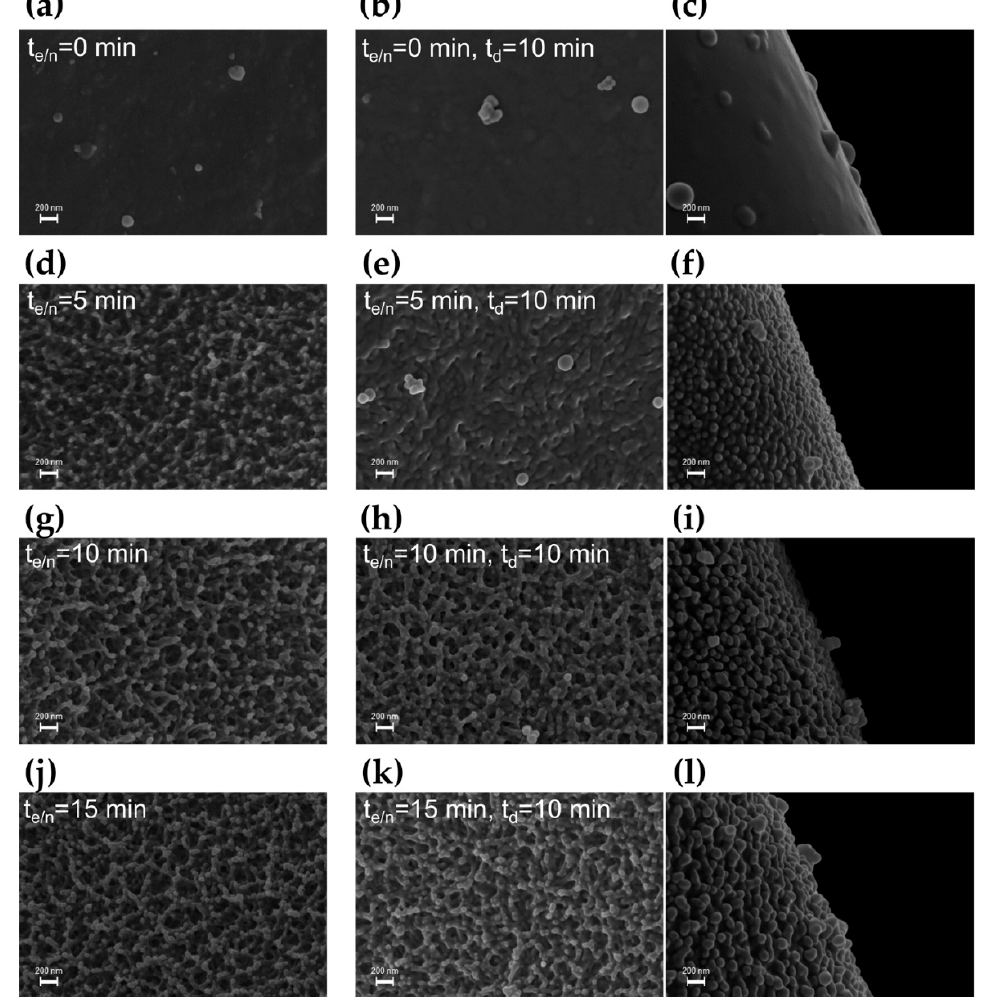
Figure 4. SEM images of the PU foams treated by the two-step plasma process, varying the duration of step 1 (t e/n = 0, 5, 10, 15 min) and fixed the duration of step 2 fixed (t d = 10 min): foam sample after step 1 with t e/n = 0 min ( a ) and overcoating with a hydrocarbon polymer thin film in step 2 ( b , c ); foam sample after step 1 with t e/n = 5 min ( d ) and overcoating in step 2 ( e , f ); foam sample after step 1 with t e/n = 10 min ( g ) and overcoating in step 2 ( h , i ); foam sample after step 1 with t e/n = 15 min ( j ) and overcoating in step 2 ( k , l ).